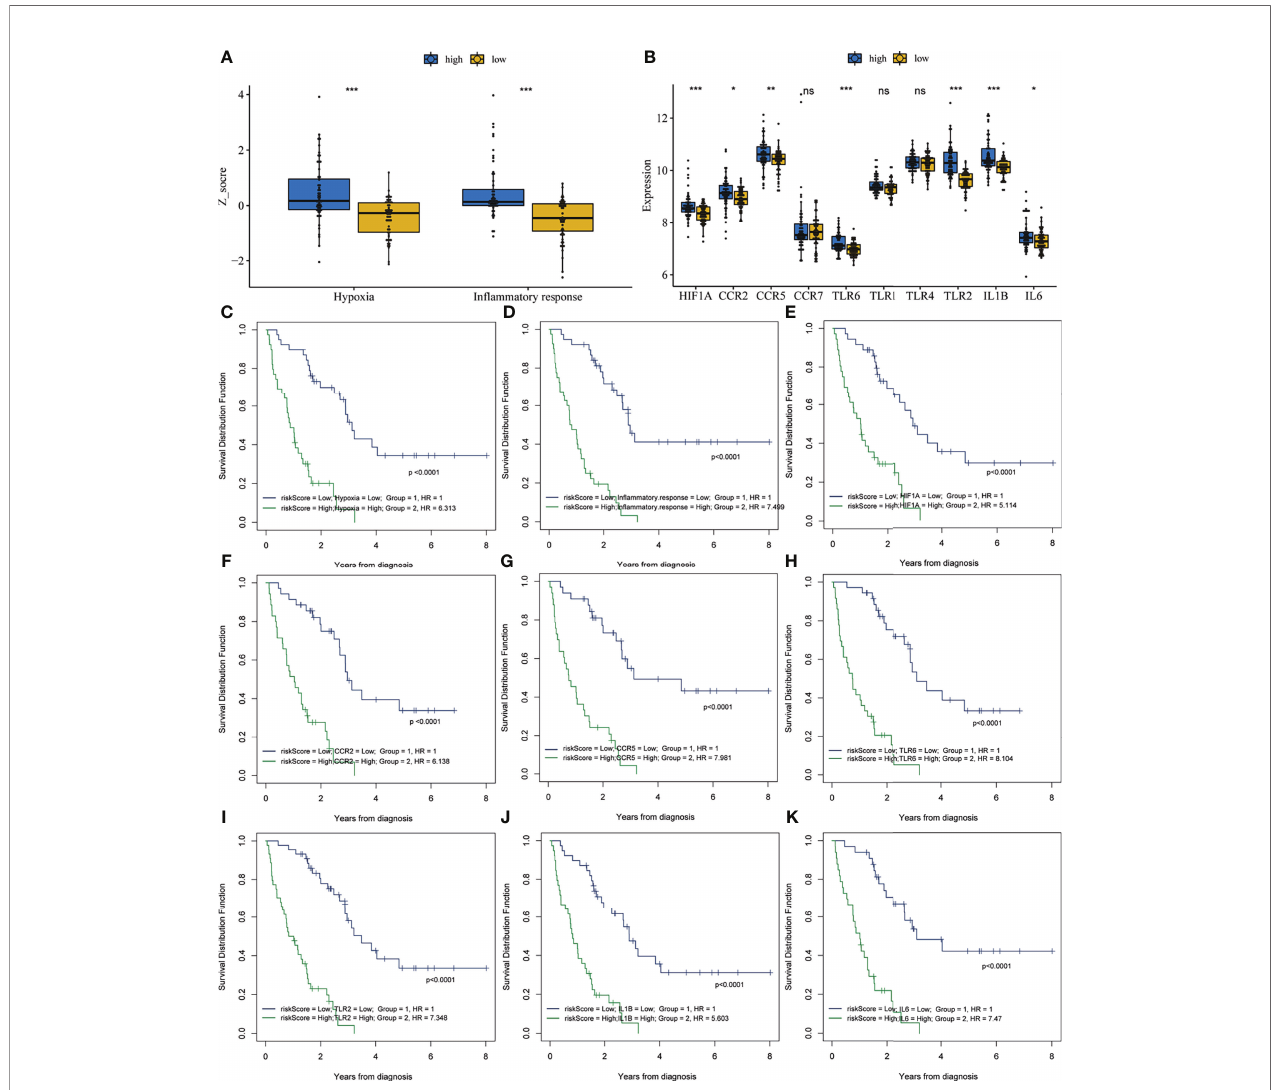
FIGURE 5 | Correlation analysis between risk score and in fl ammatory response and hypoxia. (A) The single-sample gene set enrichment analysis score of hypoxia and in fl ammatory response in the high- and low-risk groups. (B) The expression of in fl ammation response and hypoxia-related genes in the high- and low-risk groups. Survival analysis of the combination of risk score with hypoxia (C) , in fl ammatory response (D) , HIF1A (E) , CCR2 (F) , CCR5 (G) , TLR6 (H) , TLR2 (I) , IL1B (J) and IL6 (K) . *P < 0.05, **P < 0.01, ***P < 0.001, NS, no signi fi